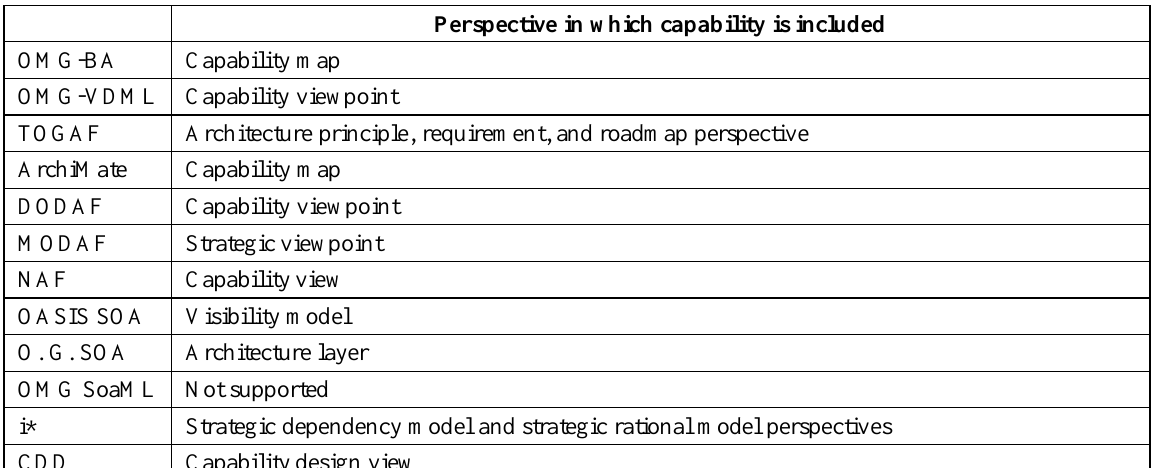
Table 3. The “Perspective” aspect of the capability concept Perspective in which capability is included